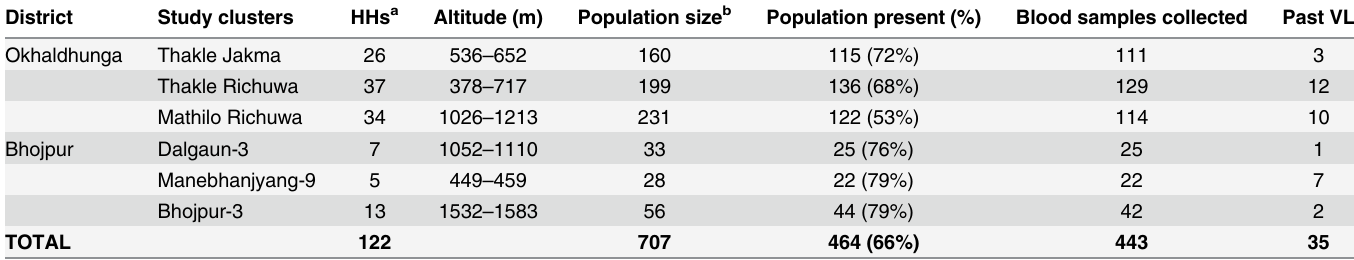
Table 1. Characteristics of study clusters.